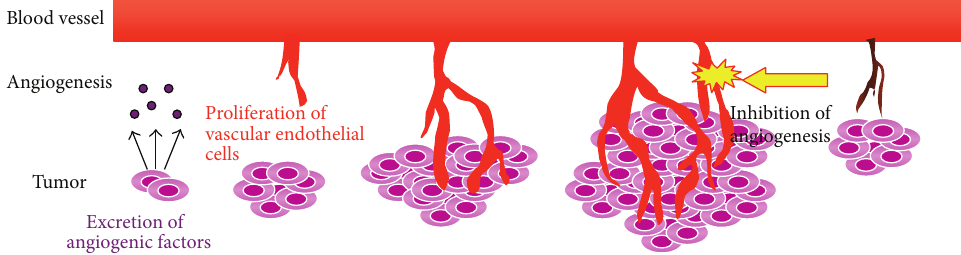
Figure 3: Depiction of tumor angiogenesis. Angiogenesis is an important tumor growth factor. Vascular endothelial cell proliferation is essential for the development of new blood